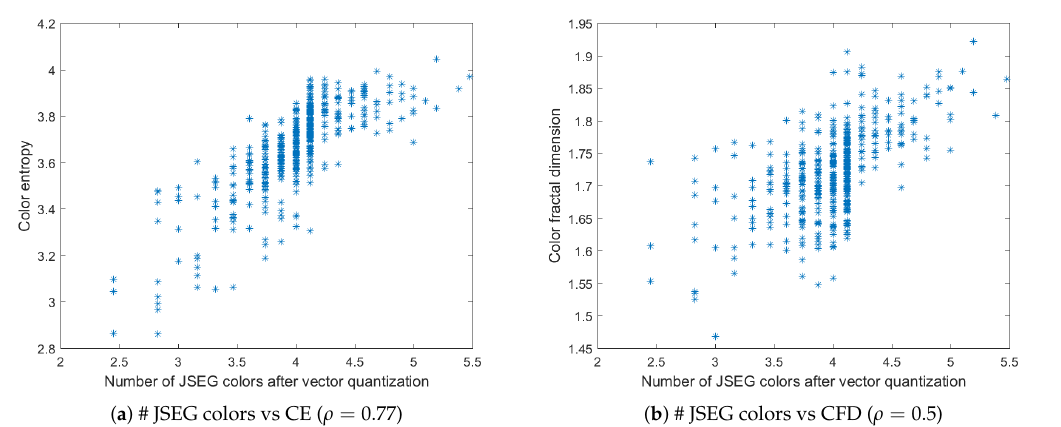
Figure 7. The number of JSEG colors after quantization versus color entropy ( a ) and color fractal dimension ( b ) for the BSDS500 data base. The corresponding Pearson correlation coefficient is given in brackets for each